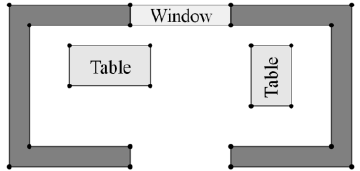
Figure 4. Two tables in a room. Three polylines are used to represent this space, one for the floor and one for each